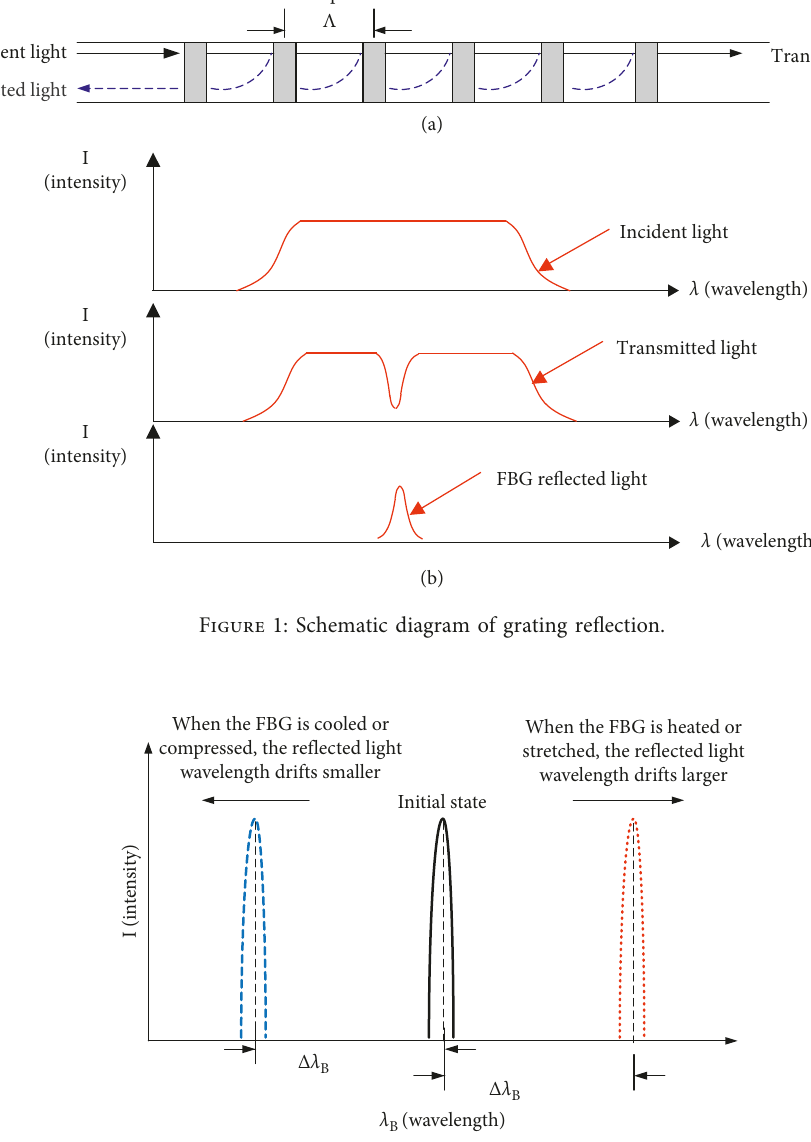
Figure 2: Schematic diagram of temperature and strain corresponding to wavelength